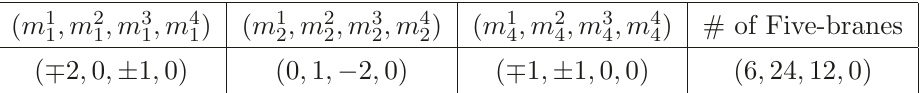
Table 4 . Number of heterotic five-branes in the basis ( w 1 , w 2 , w 3 , w 4 ) and the first Chern numbers c i ( L a ) = m i in agreement with all the requirements, where other line bundles are constrained as a 1 c 1 ( L 5 ) = c 1 ( L 4 ) and c 1 ( L 3 ) = 0. We omit the other sign flipping and possible permutations − among the m i . The list of this table gives rise to the vanishing indices of Higgs fields L 4 , 5 a